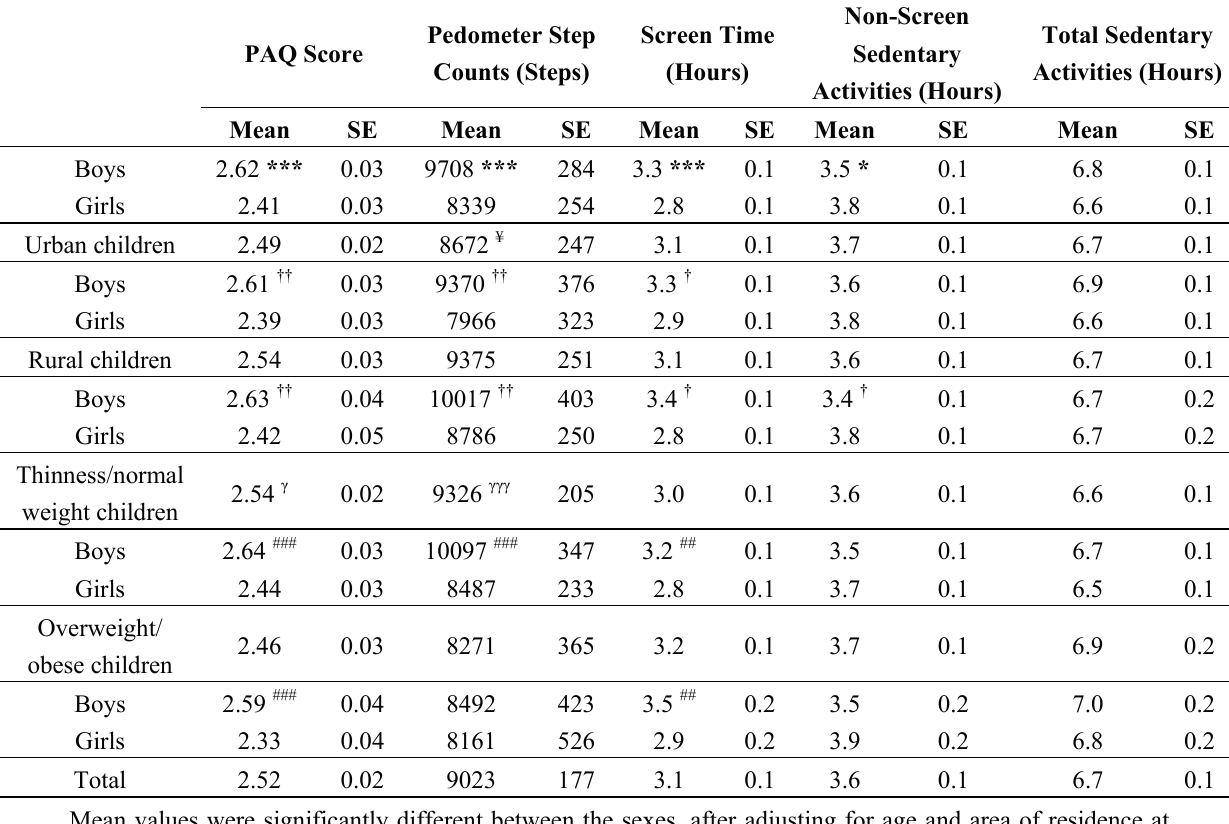
Table 3. Physical activity and time spent on sedentary activities of children according to sex, residential area and BMI